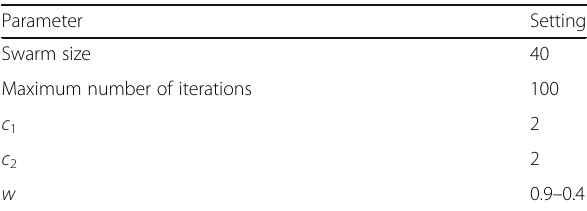
Table 2 PSO parameters Parameter Setting